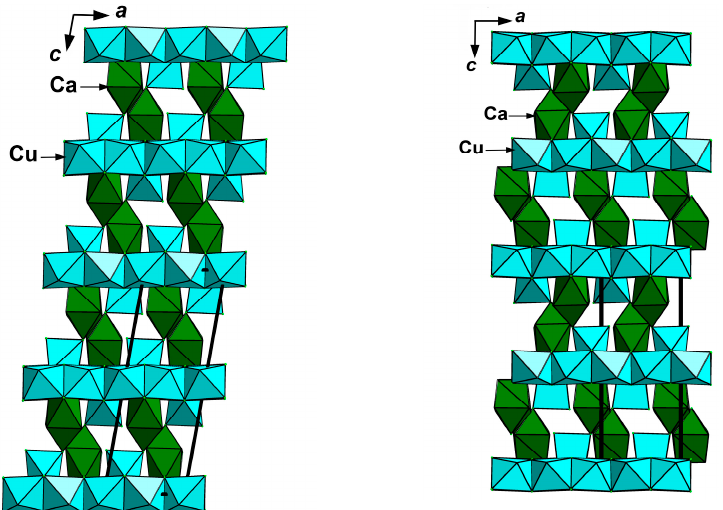
Figure 4. The crystal structures of dioskouriite-2 M (left drawing) and dioskouriite-2 O (right drawing) projected along the b axis. Only cation-centered polyhedra are shown. The unit cells are outlined.